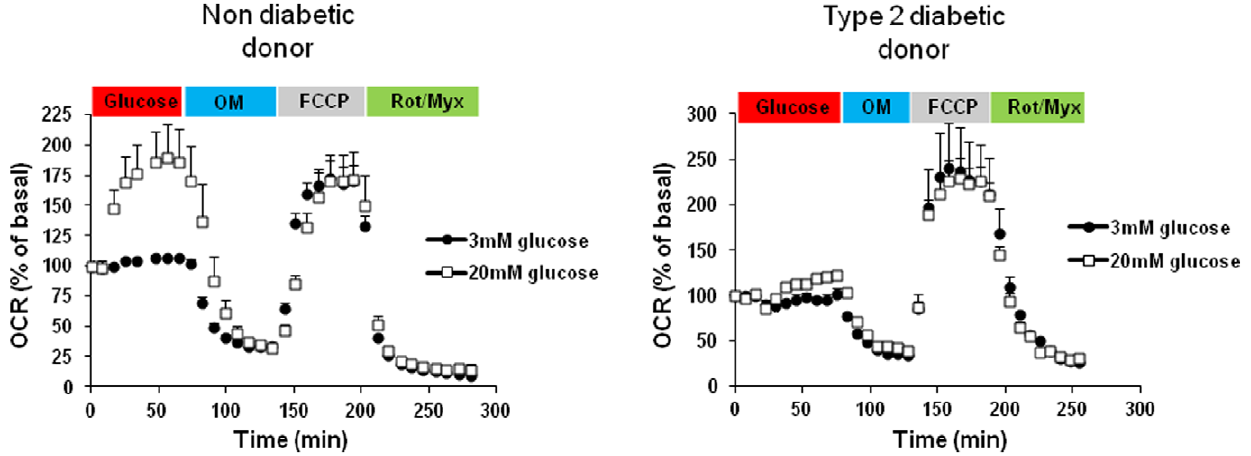
Figure 4. Respiration of a small cohort of human Type 2 diabetic islets. Each graph represents islets from one patient (n=4 2 5). Drugs added during the experiment are indicated. Type 2 diabetic donor: Male age 52, weight 100 kg, BMI 31.9, Caucasian. Non diabetic donor: Male age 32, weight 69 kg, BMI 24.7, Caucasian.